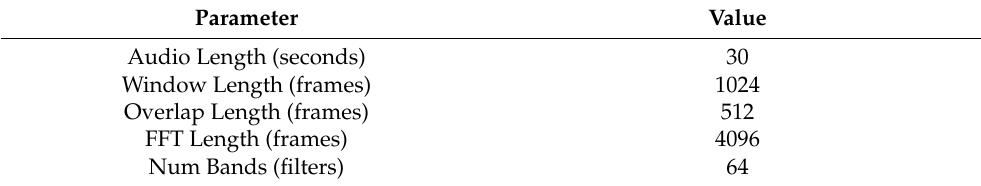
Table 2. Parameters of visual Mel